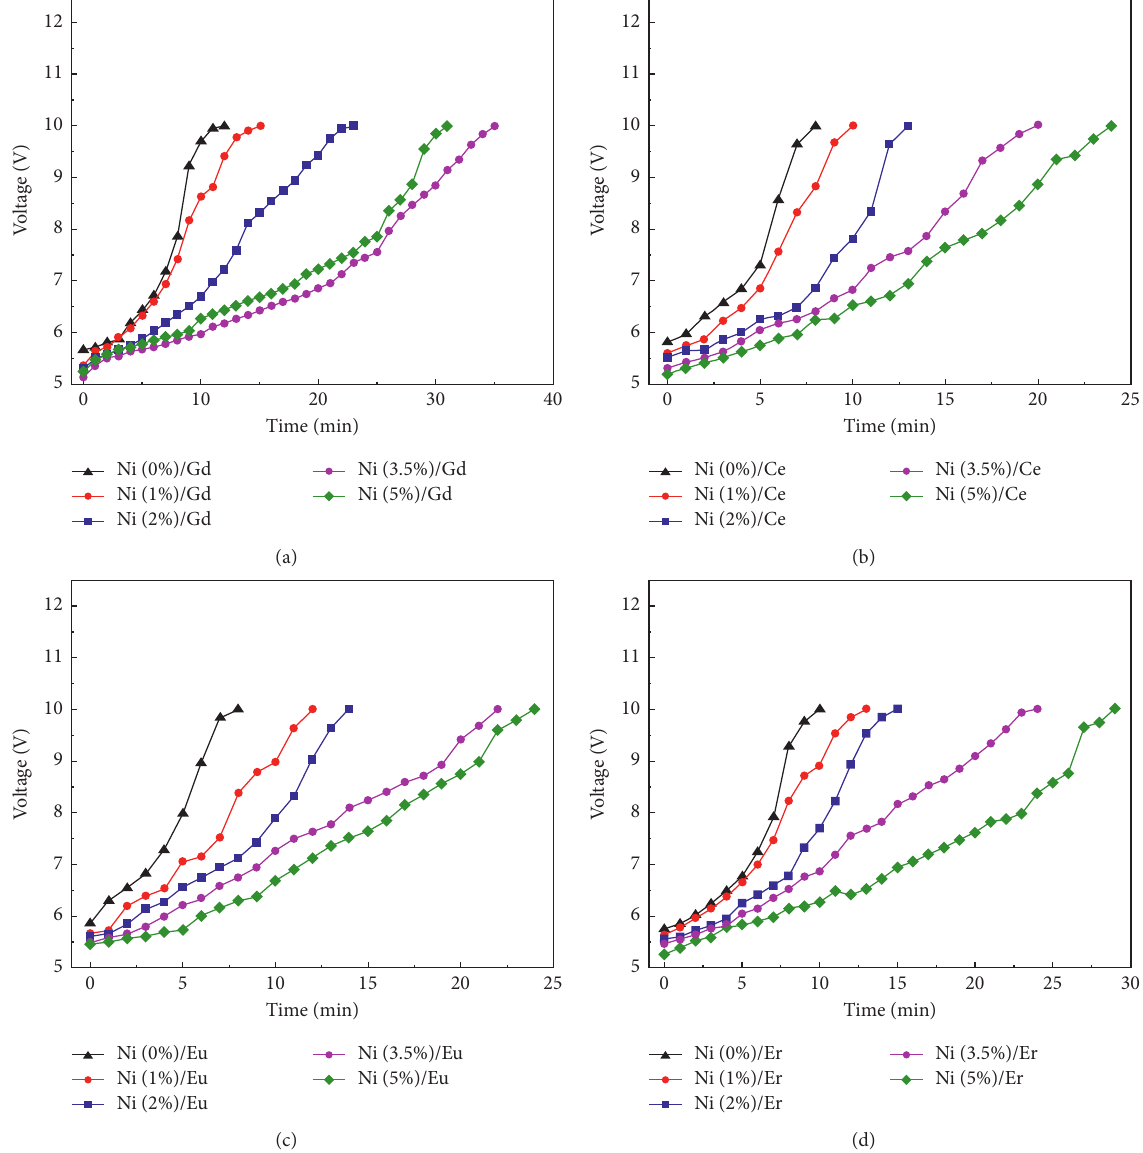
Figure 16: Accelerated life curves of Ti/SnO 2 -Sb-Ni/Re electrodes modified with various Ni contents in 1.0 mol density of 1000mA · cm − 2 at 40 ° C (Re � (a) Gd, (b) Ce, (c) Eu, and (d) Er